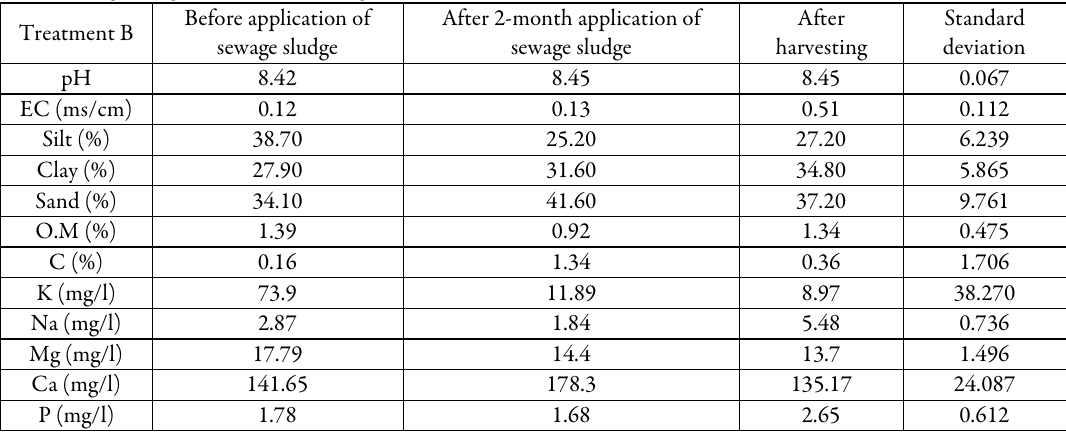
Table 5. Mean values of physicochemical parameters of soil with sewage sludge before application of sewage sludge and after harvesting Before application of Treatment B